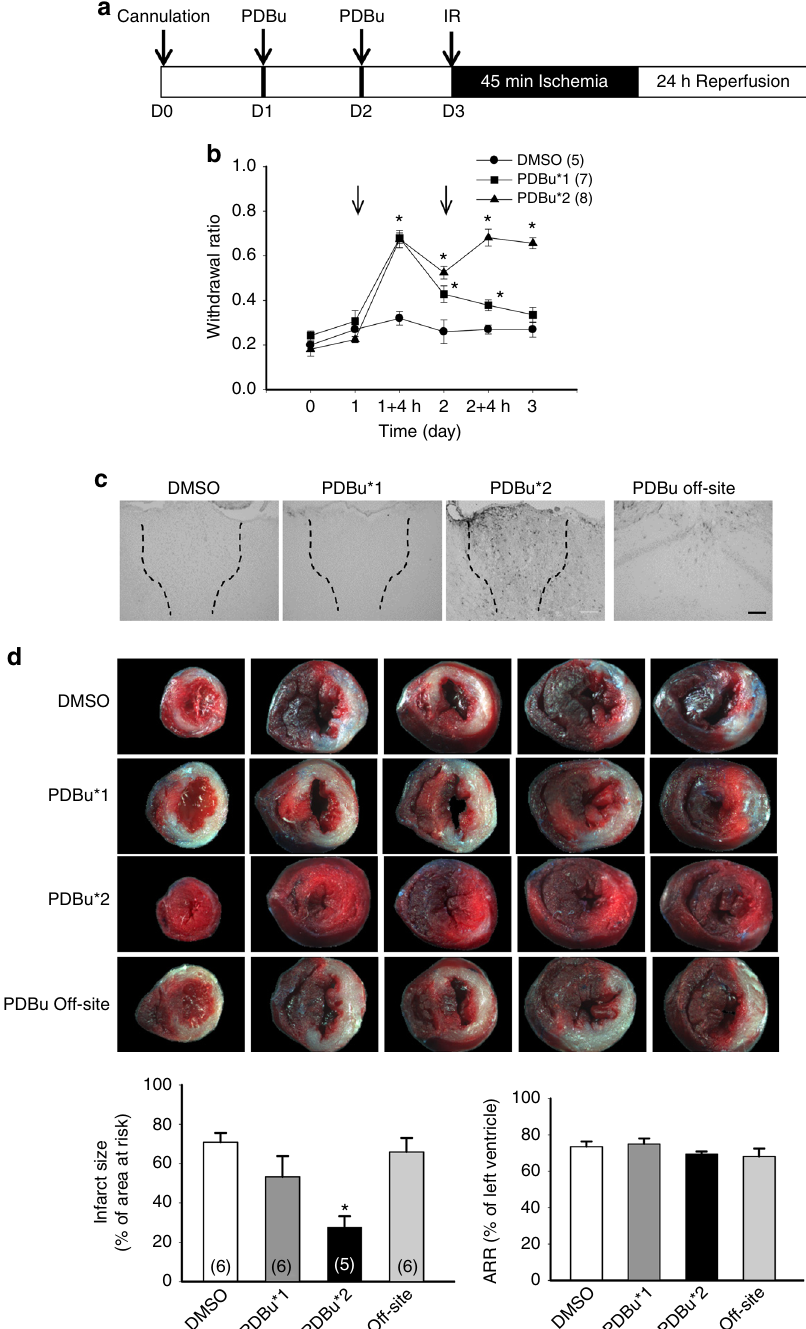
Fig. 5 Infusion of PDBu in PVA induce cardioprotection in naïve animals. a Schematic of experimental design showing the timeline for cannulation (D0), intra-PVA infusion of PDBu (20 pmol in 0.3 μ L 50% dimethyl sulfoxide (DMSO)) or 50% DMSO (D1, D2), and myocardial IR surgery (D3). b Mechanical responses of hind paws at D0 (basal), D1, D1 4 h after fi rst PDBu infusion, D2, D2 4 h after 2nd PDBu infusion and D3. * p < 0.05 vs. DMSO group. Arrow indicates intra-PVA infusion of PDBu. c Immunohistochemical staining of pERK in PVA (outlined by dashed line ) from animals received PDBu and DMSO infusion. Scale bar = 100 μ m. PDBu*1, infusion of PDBu (D1) and infusion of 50% DMSO (D2) in PVA. PDBu*2, infusion of PDBu at D1 and D2 in PVA. PDBu off-site, infusion of PDBu at D1 and D2 in CA1 region of hippocampus. Scale bar = 100 μ m. d Representative images of TTC staining in heart cross-sections. Quanti fi cation results of infarct size and AAR in cardiac sections from different treatment groups ( lower panel ). Two infusions of PDBu in PVA were suf fi cient to induce cardioprotection in naïve animals. * p < 0.05 vs. DMSO group. Error bars indicate SEM. Statistical signi fi cance was determined by two-way RM ANOVA ( b ) or one-way ANOVA ( d